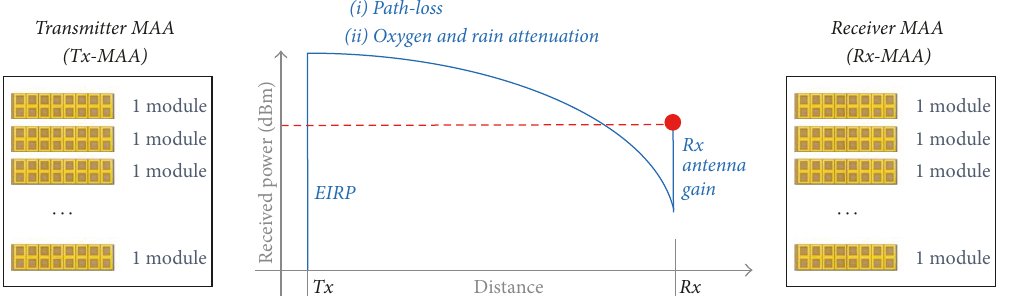
Figure 3: Link budget calculation